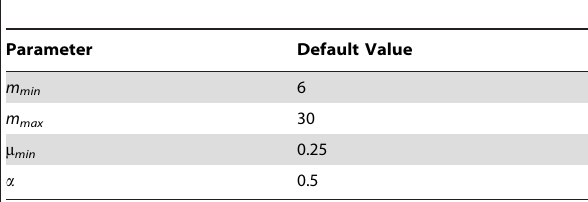
Table 1. Choice of Parameters in Cutoff